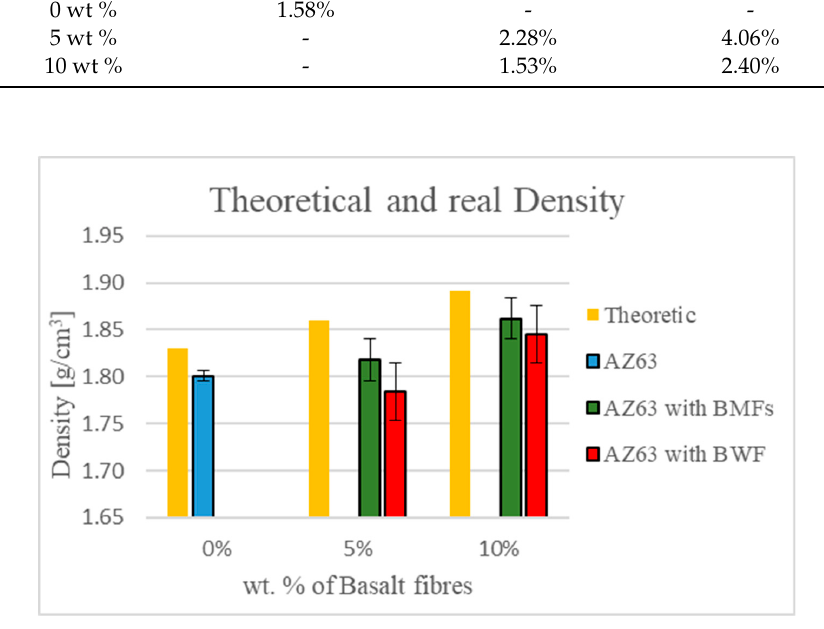
Figure 6. Comparison of theoretical and measured density of composites obtained.